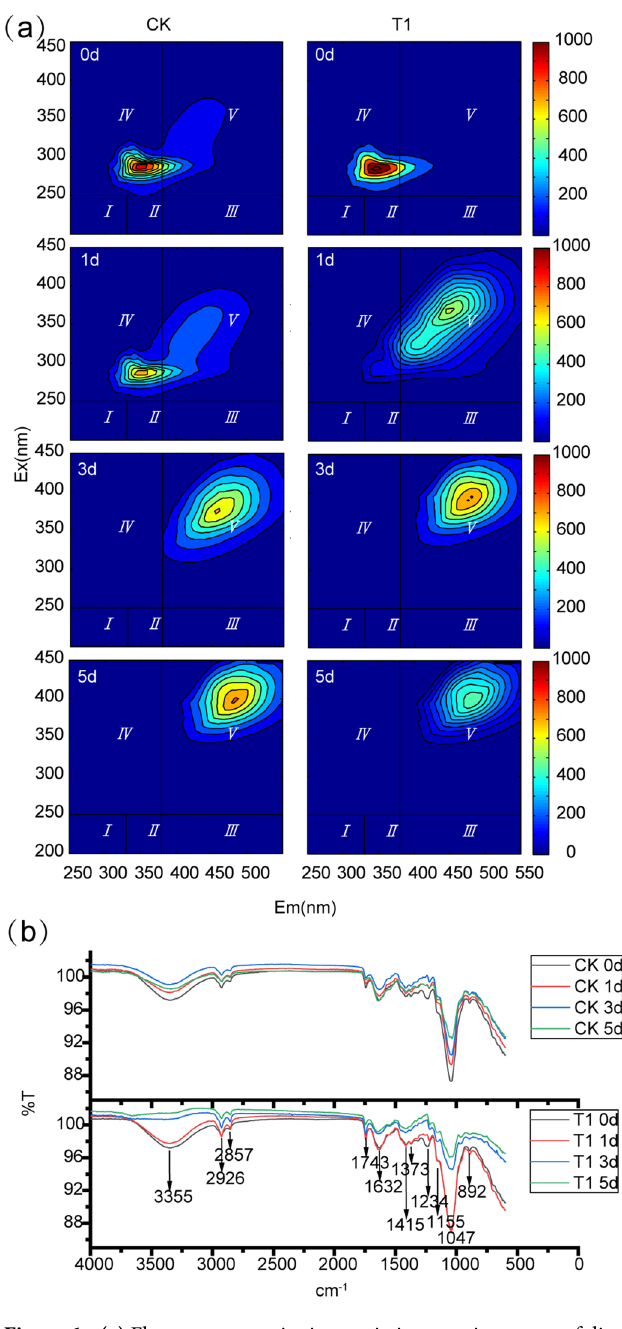
Figure 6. (a) Fluorescence excitation-emission matrix spectra of dissolved organic matter in CK and T1. Em (nm): emission wavelength (nm); Ex (nm): excitation wavelength (nm). Regions I and II: simple aromatic proteins; Region III: fulvic acid-like substances; Region IV: soluble microbial byproducts; and Region V: humic acid-like substances. (b) The 4000-to-600-cm −1 regions of the Fourier transform infrared spectra of CK and